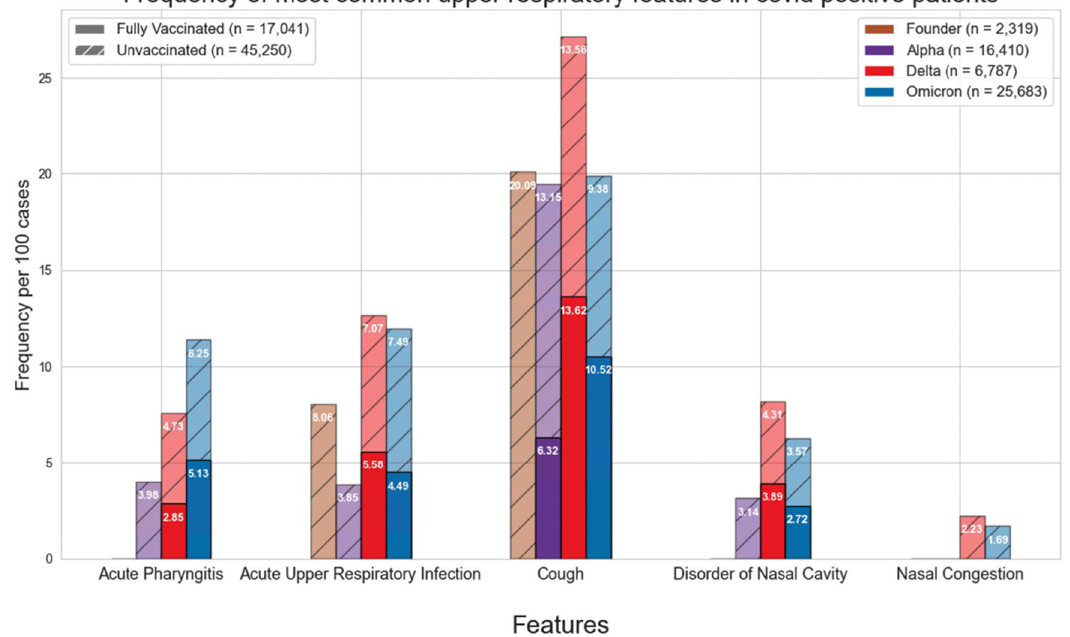
Figure 2. Comparison of frequency of most common upper respiratory features in COVID positive patients based on fully vaccinated or unvaccinated status.